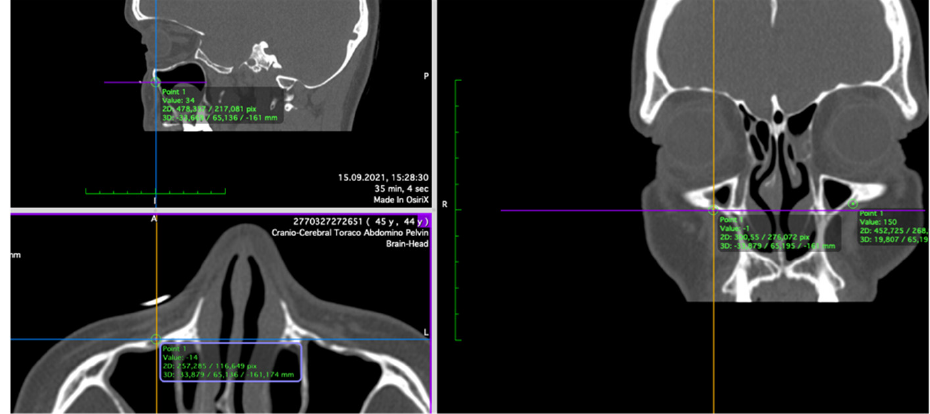
Figure 2. Placement of the right IOF point.